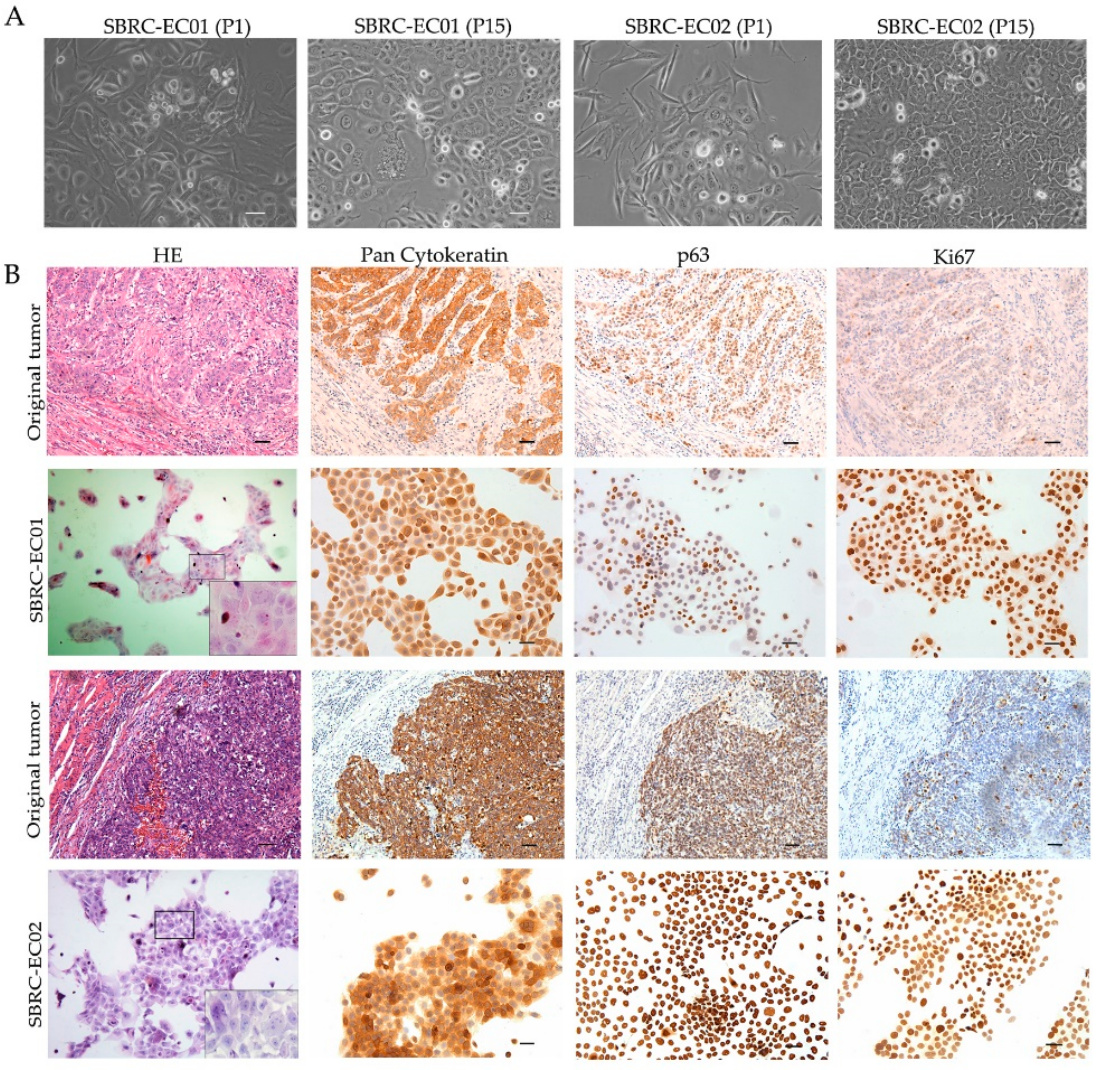
Figure 1. SBRC-EC01 and SBRC-EC02 mimic the biological characteristics of the primary tumors. ( A ) Phase contrast images of SBRC-EC01 and SBRC-EC02 at different passages are presented. Polygonal epithelial-like cells were surrounded by long fusiform cells at passage 1. At passage 15, cells of different shapes and sizes were observed; ( B ) Histopathological examination of the original tumors and the derived cell populations. Immunostaining for Pan Cytokeratin (AE1/AE3), Ki67, p63 are shown. Scale bar: 50 µm.